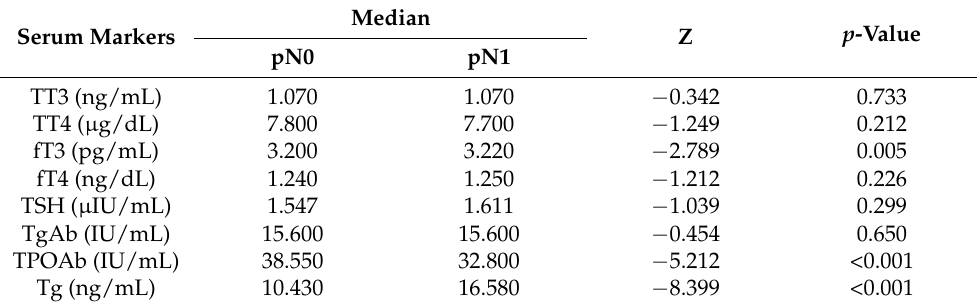
Table 3. Comparison of serum marker results between the pN0 and pN1 groups.